Question: Describe this figure in one sentence.
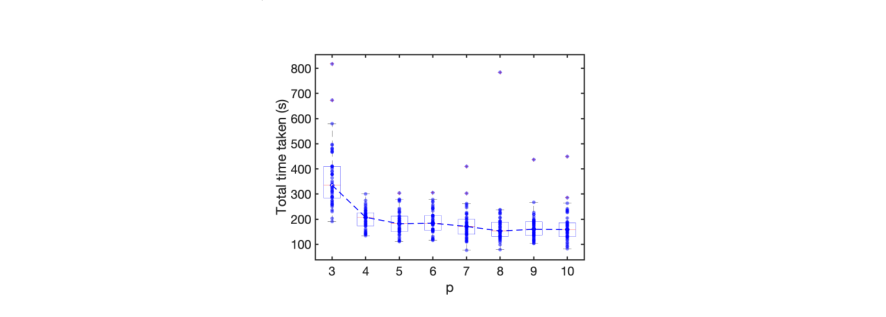
Answer: The total time taken for task completion as a function of p. study the effect of the considered parameter on the emergent behavior by keeping other conditions constant. Stochasticity within each simulation originates from the random selection of θr. All robots in the swarm move at different rotational and translational speeds.